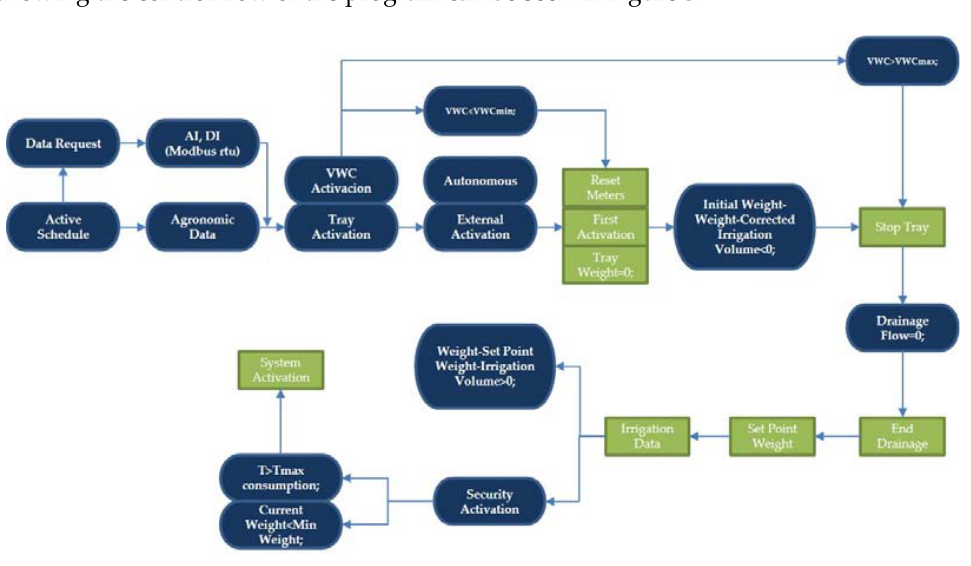
Figure 3. Grafcet of the process. In rounded blue: conditions, calculations, and data. In square green: actions.